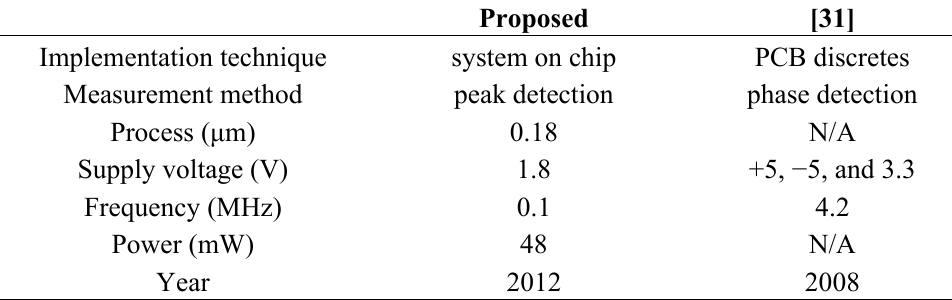
Table 3. Comparison with prior